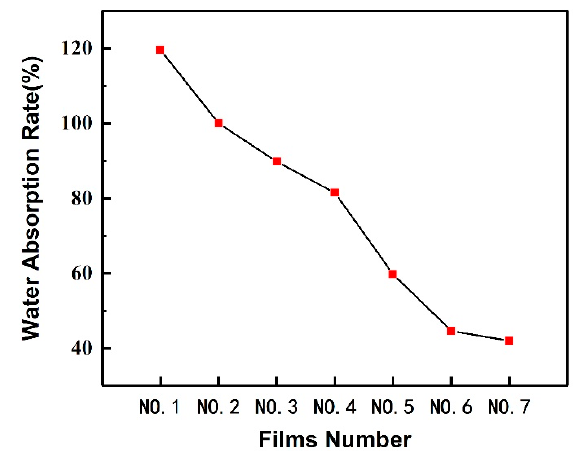
Figure 4. Water absorption performance of the films.